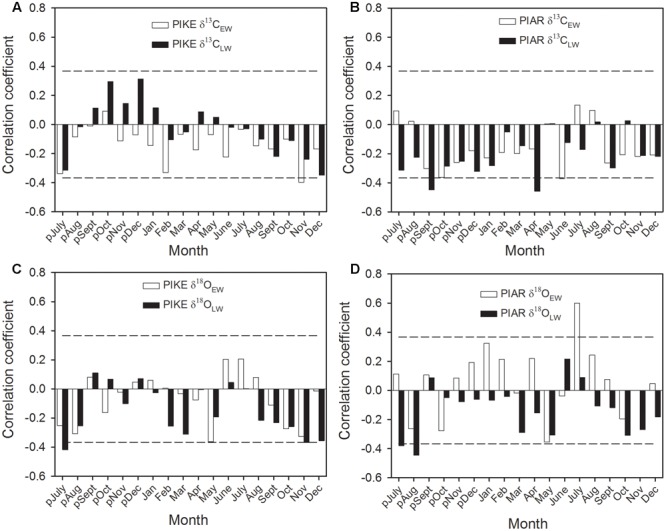
Correlations of carbon isotope in earlywood (δ13CEW, open bar) and latewood (δ13CLW, closed bar) of secondary forest pine P. kesiya (PIKE) (A), and natural forest pine P. armandii (PIAR) (B), oxygen isotope in earlywood (δ18OEW) and latewood (δ18OLW) of P. kesiya (PIKE) (C), and δ18OEW and δ18OLW of P. armandii
(D) and relative humidity (RH) from Ailaoshan Station for Subtropical Forest Ecosystem Studies (ALS) (1982–2012). The dashed lines indicated the 95% confidence intervals.